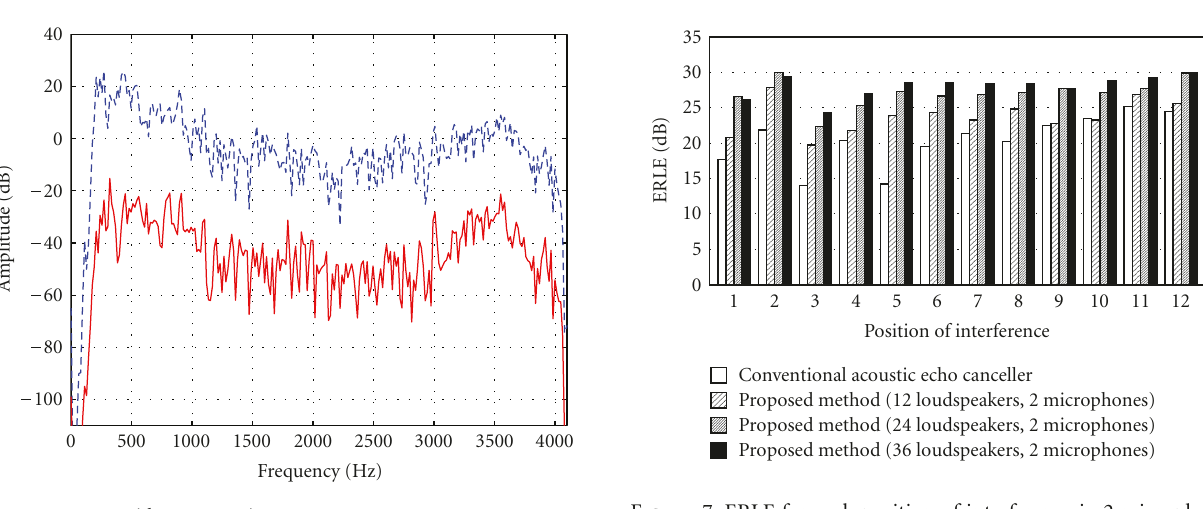
Figure 7: ERLE for each position of interference in 2 microphone elements. The horizontal axis represents the position of interference in Figure